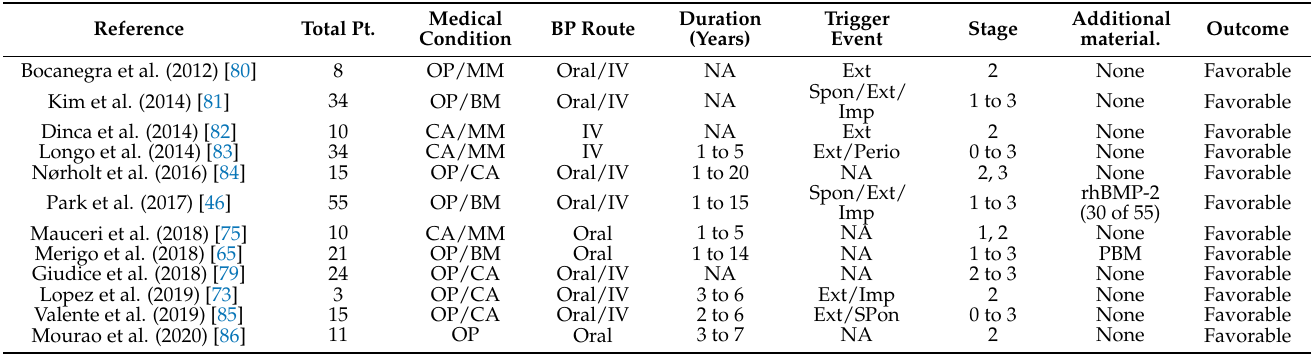
Table 5. Human studies of platelet concentrates (PC) administration for MRONJ treatment in the past 10